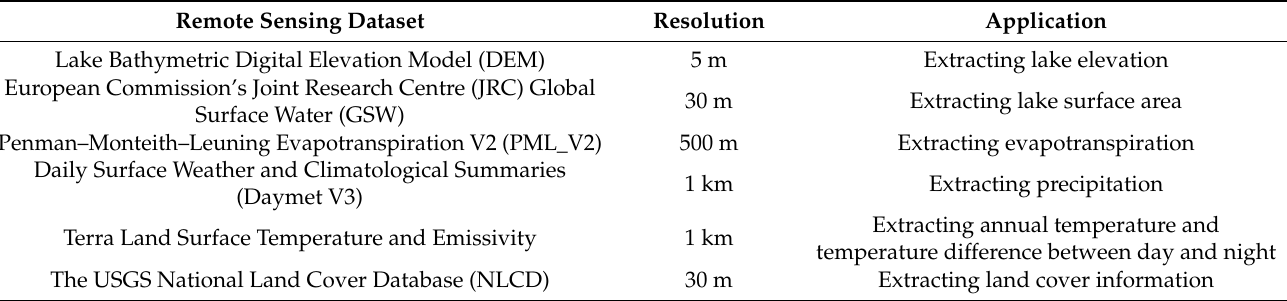
Table 1. Multi-source remote sensing datasets used in this study.